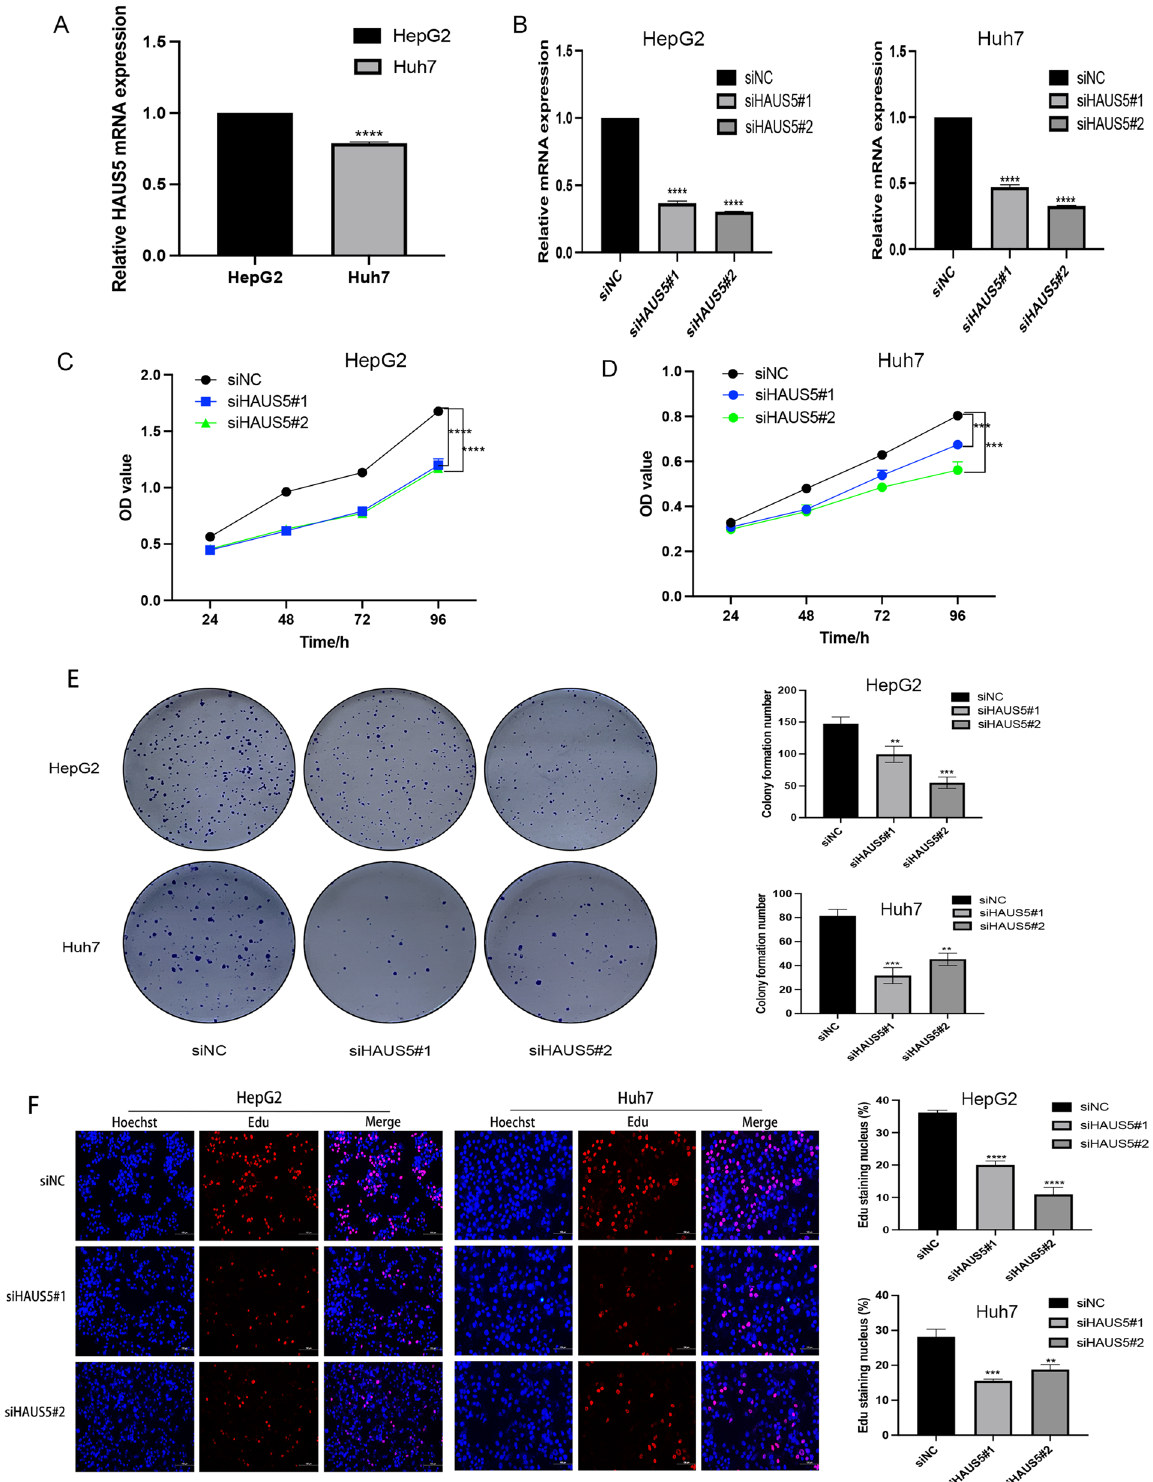
Figure 9. The effect of knockdown of HAUS5 on cell proliferation. ( A ) The level of HAUS5 expression in HepG2 and Huh7. ( B ) qRT ‒ PCR indicated that HAUS5 expression was decreased after knockdown of HAUS5 in HepG2 and Huh7 cells. ( C , D ) CCK-8 assay and ( E ) cell colony formation assay showed that cell proliferation was inhibited. ( F ) EdU assays showed that the capability of DNA replication decreased in cells with HAUS5 knockdown. *P < 0.05, **P < 0.01, ***P < 0.001, ****P <